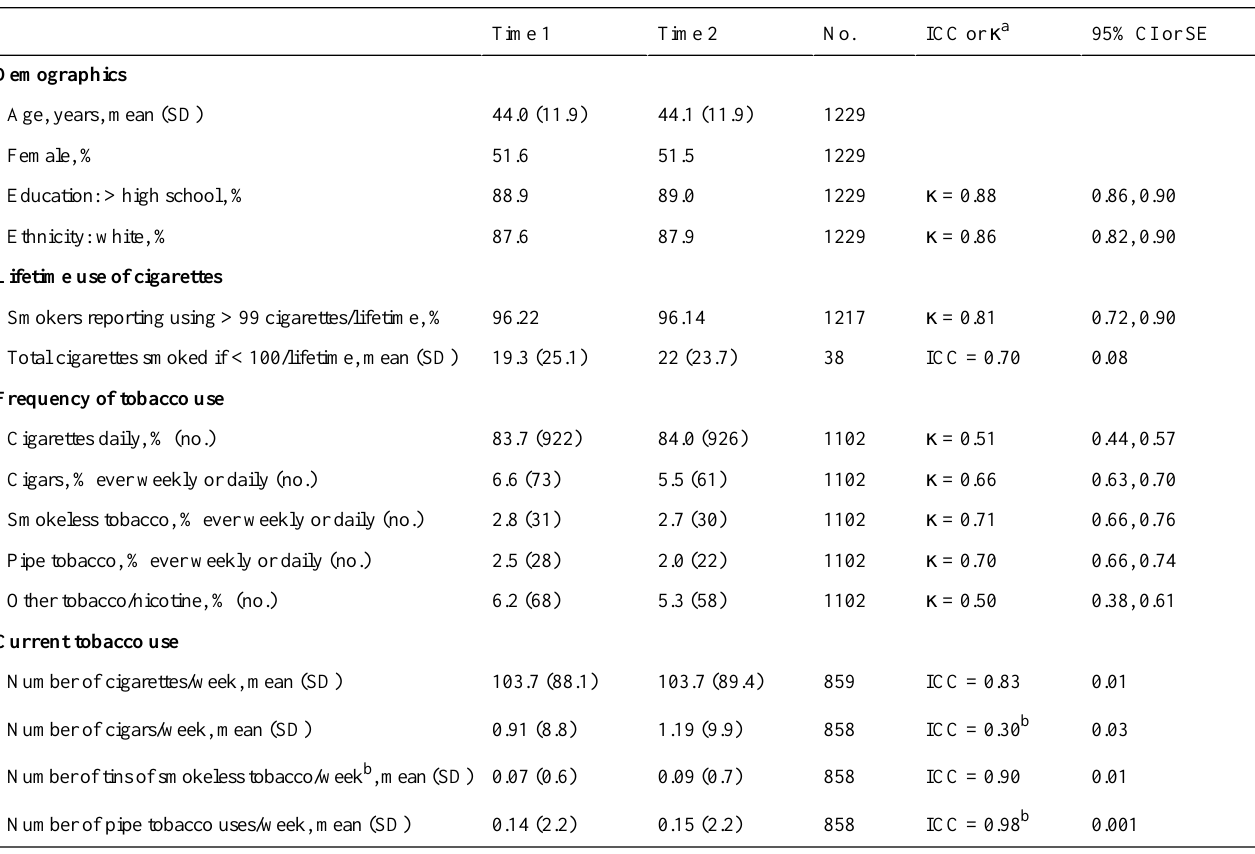
Table 1. Test-retest reliability of respondents’self-report of demographics and tobacco